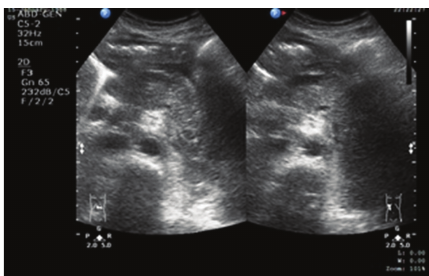
Figure 1: A bulky and inhomogeneous pancreas with presence of peripancreatic fluid in keeping with acute